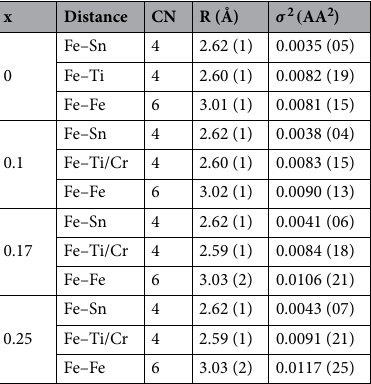
2 ), coordination number (CN), extracted from Cr x x Sn compositions, measured at 30 −